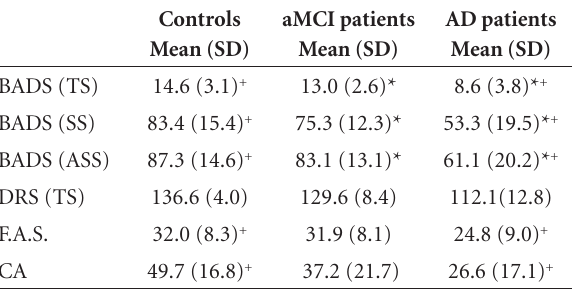
Table 2. Comparison among control subjects, aMCI patients, and AD patients on BADS, DRS, F.A.S. and